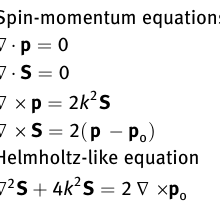
Table  : Spin-momentum equations for the single polarized EM evanescent waves [ 